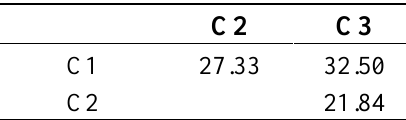
Table 2. Matrix of Euclidian distances (in% of relative humidity (RH)) between the final cluster centres for cluster analysis of data recorded before installing the expanded clay and